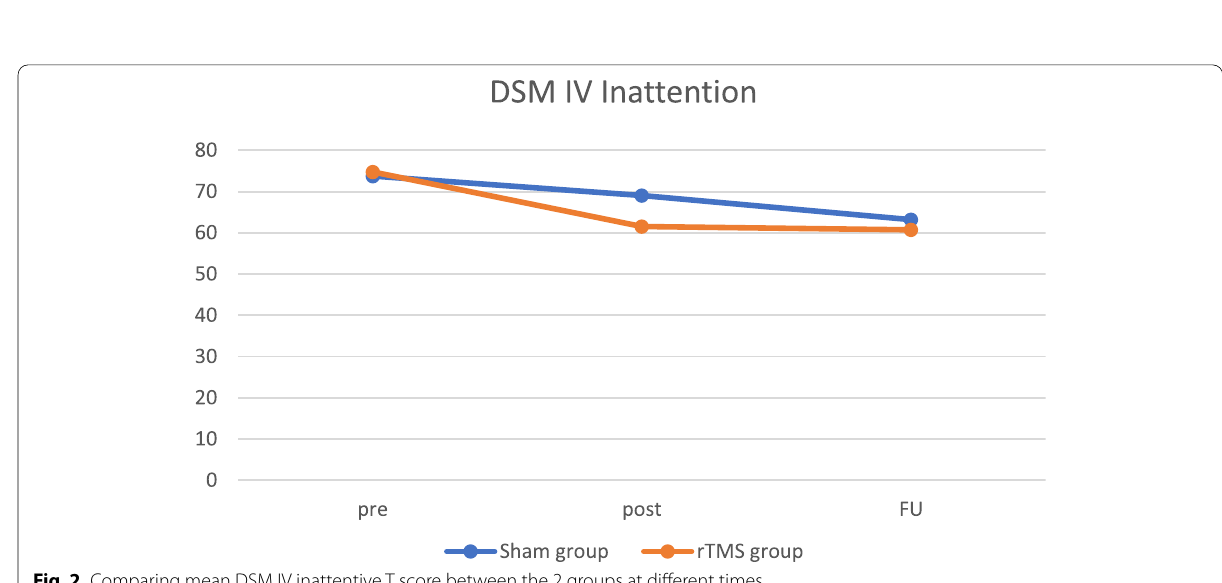
Fig. 2 Comparing mean DSM IV inattentive T score between the 2 groups at different times